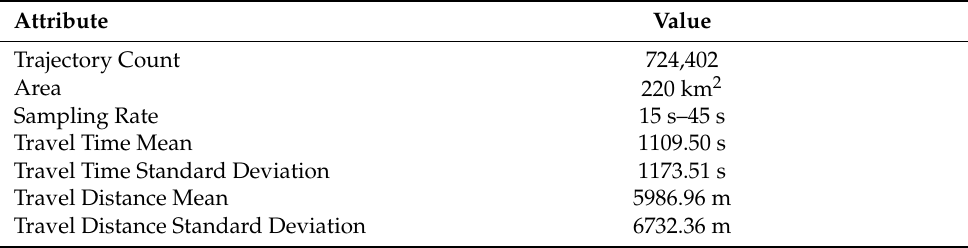
Table 1. A summary of the FCD dataset.